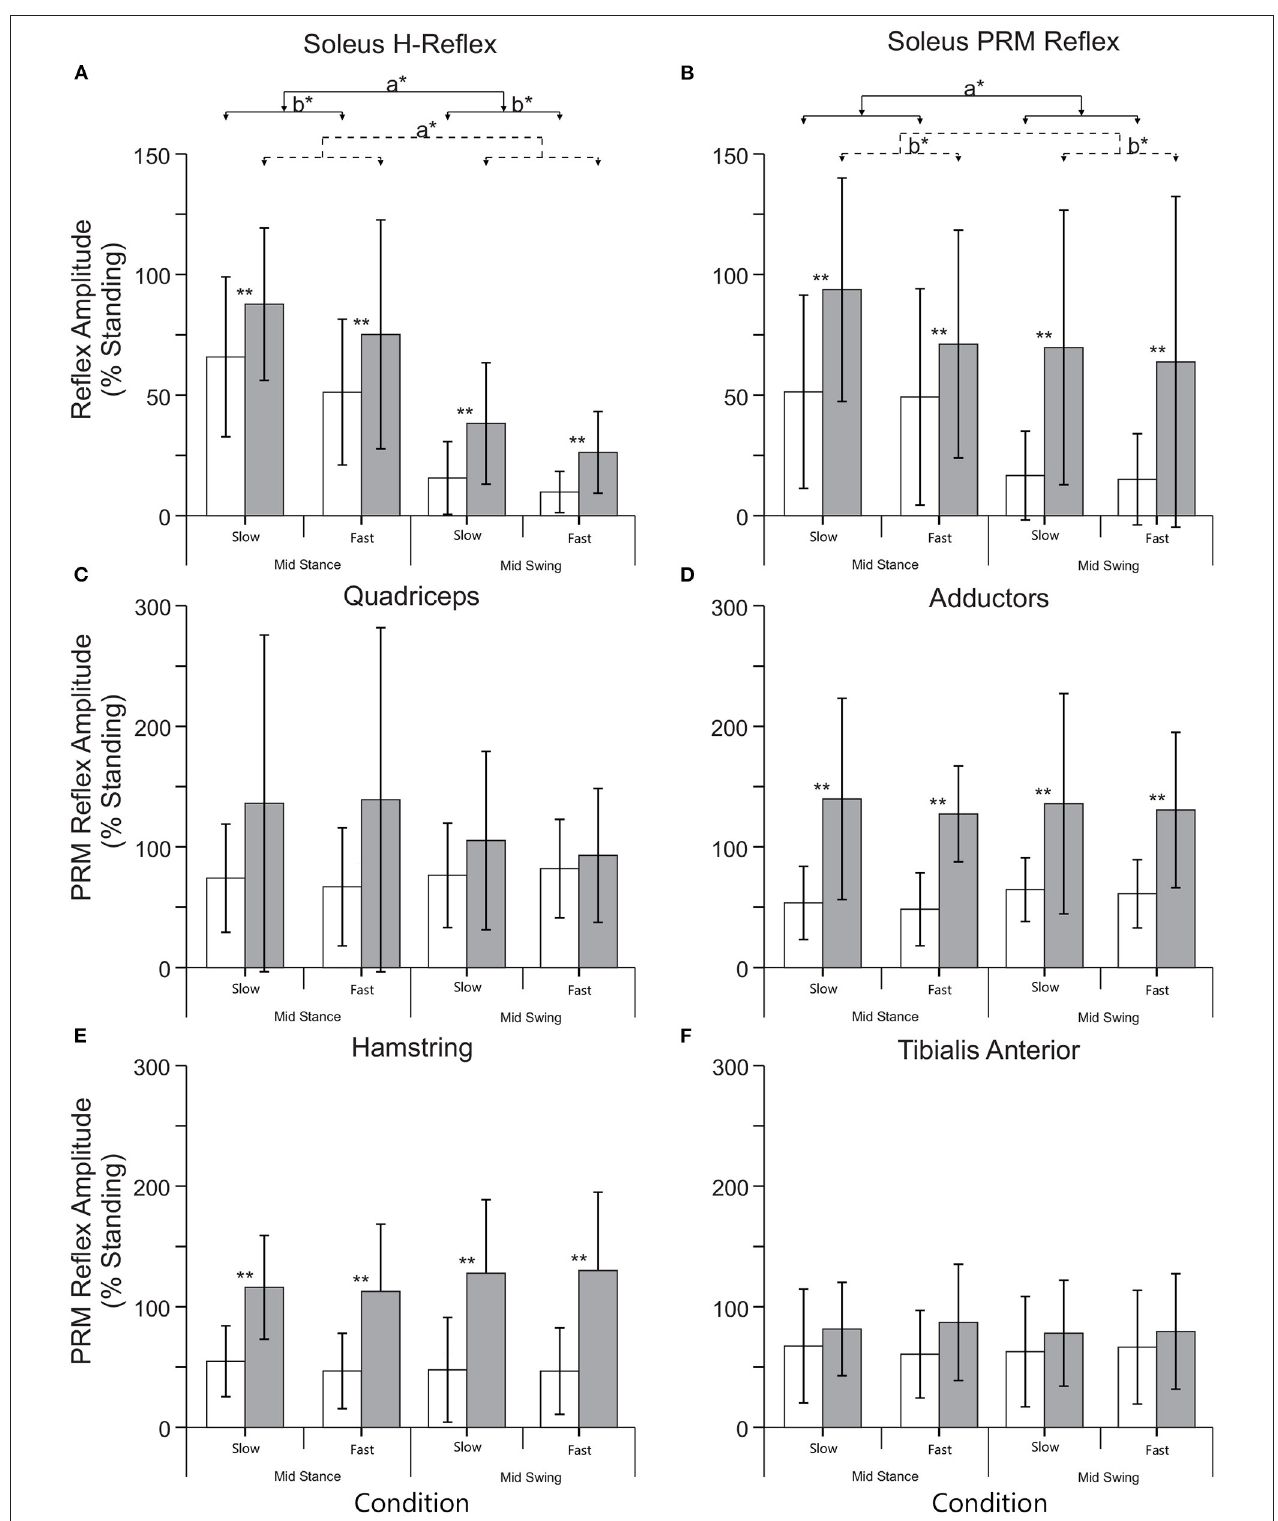
FIGURE 3 | Mean ( + SD) reflex amplitudes for each phase (mid stance and swing) and speed (slow: 0.5 m/s and fast: 0.69 m/s) of stepping for the NI (open) and SCI (filled) groups. (A) Normalized soleus H reflex amplitude during stepping. (B) Normalized soleus PRM reflex amplitude during stepping. (C–F) PRM reflex amplitudes from the remaining lower limb muscles during stepping. **Indicates an significant difference between the NI and SCI groups, a* indicates a significant effect of phase, and b* indicates a significant effect of speed. There were no significant differences in speed or phase in muscles other than the soleus.